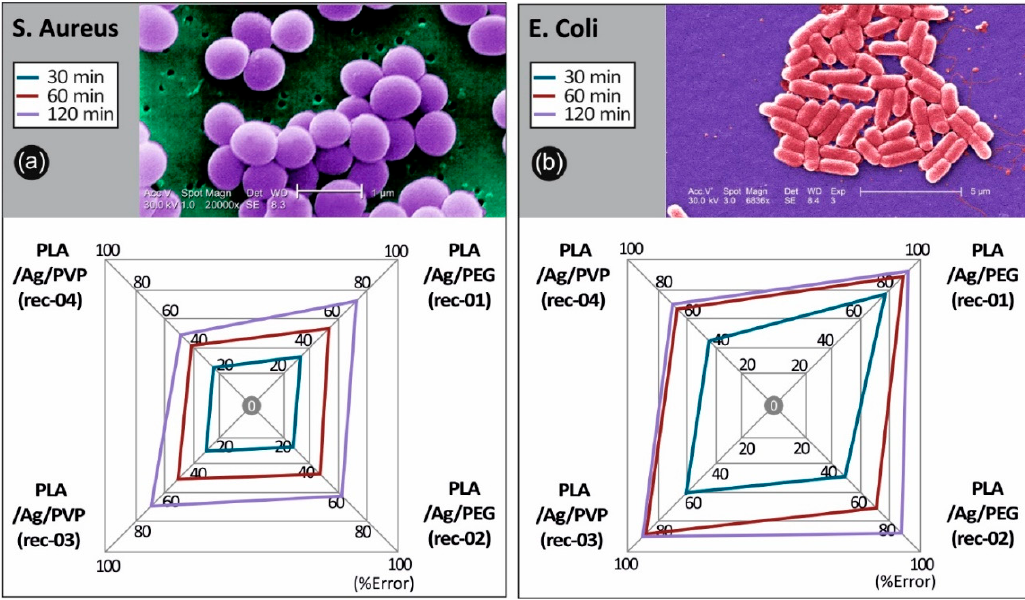
Figure 10. Comparative spider graphs for the antibacterial behavior for the four 3D printed PLA/AgNP nanocomposites produced in this work (with 100 µm 3D printed layer thickness) against ( a ) S. aureus and ( b ) E. coli after 30, 60, and 120 min of contact. Values are mean. Mean values do not differ significantly ( p < 0.05).